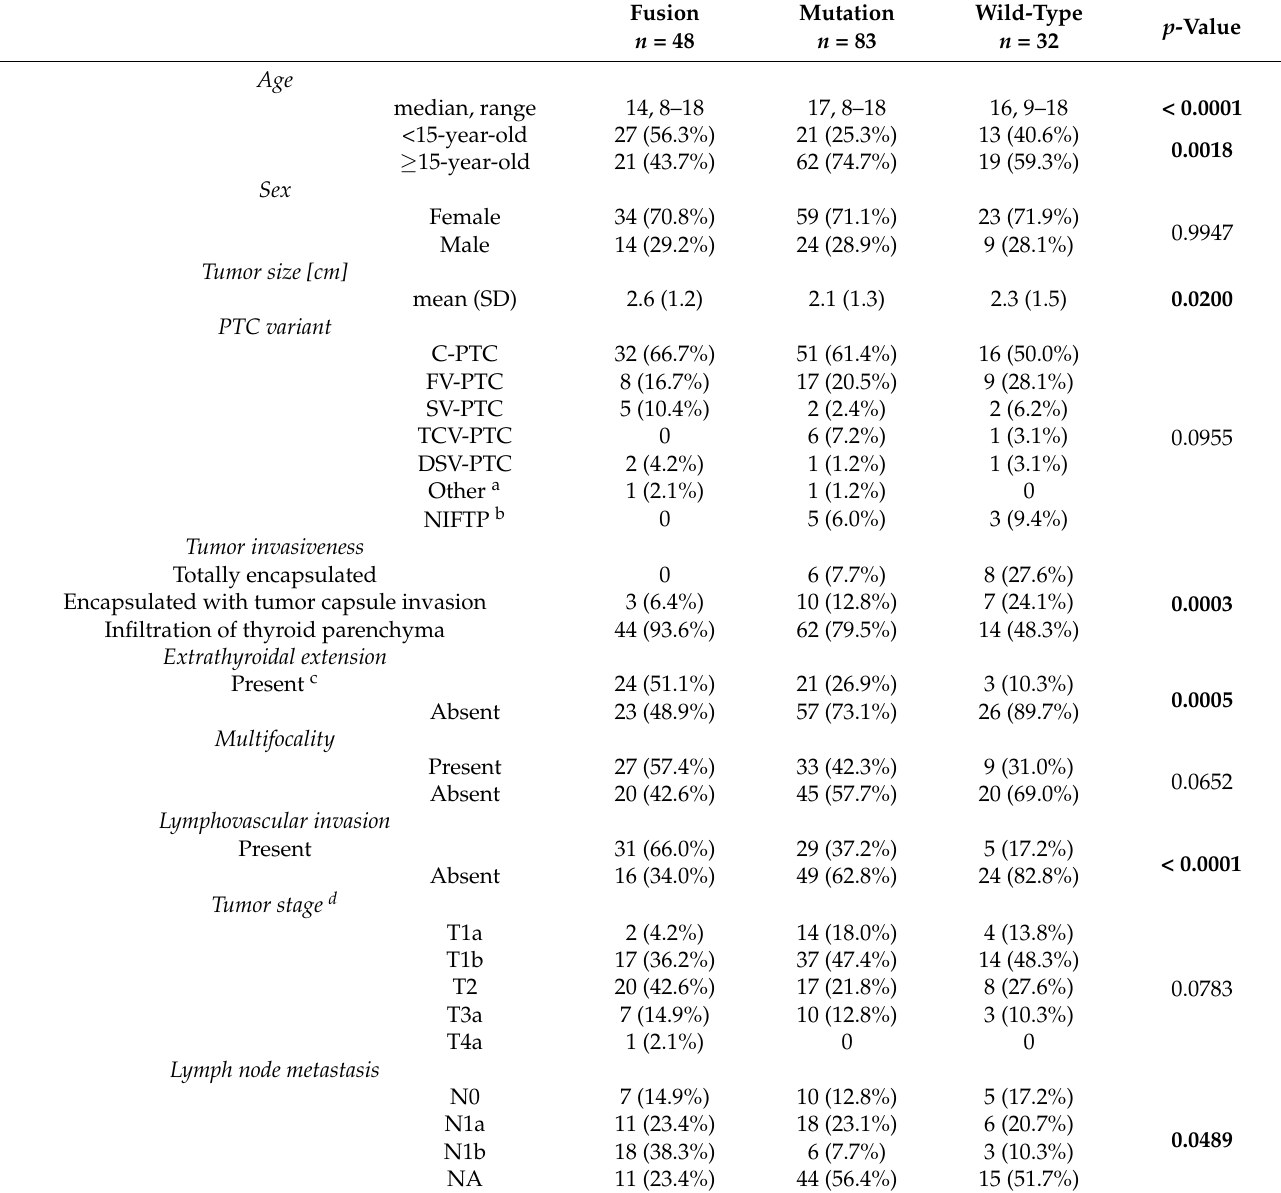
Table 2. Statistical comparison between fusion-driven and point mutation-driven pediatric